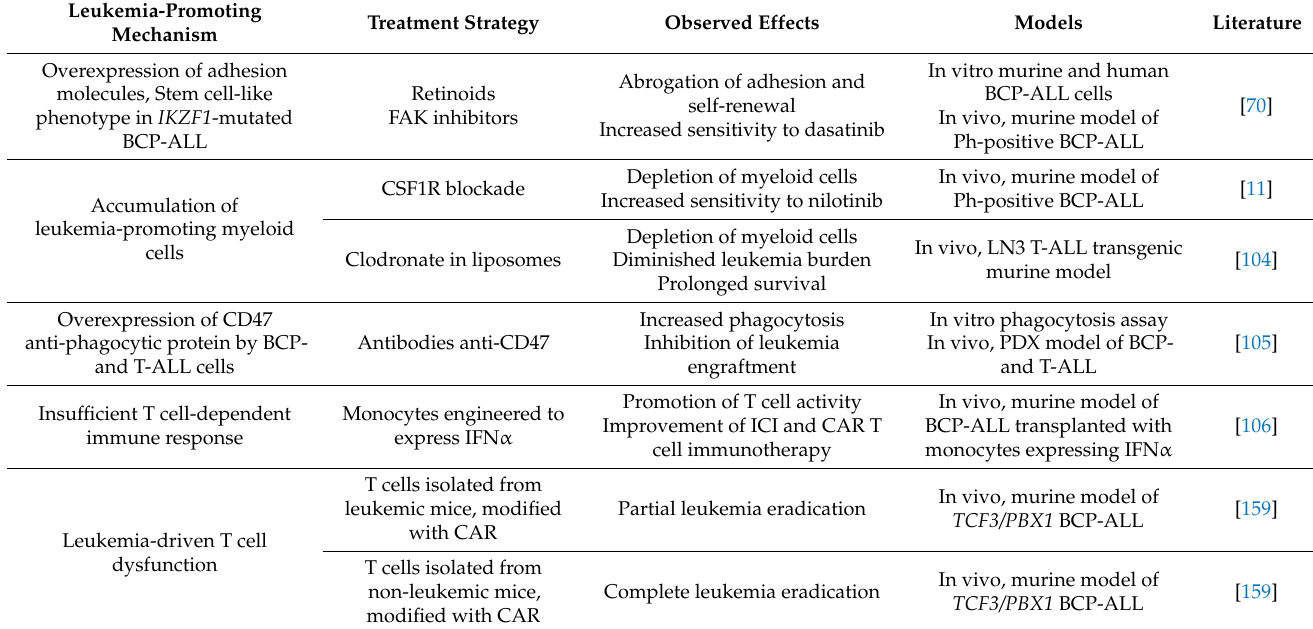
Table 5. Overcoming immune evasion and targeting leukemia-promoting interactions provided by the cells of the bone marrow niche—preclinical